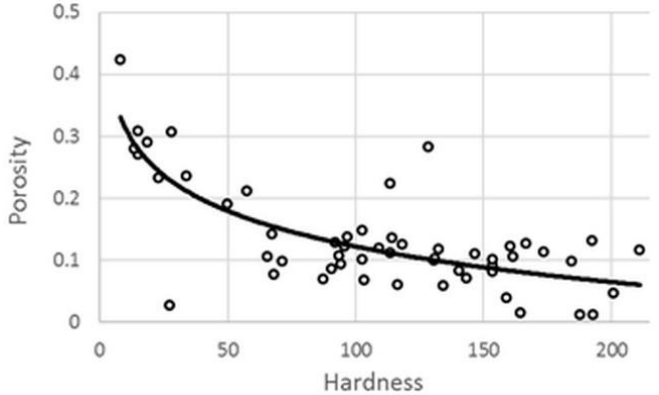
Figure 1. Hardness – porosity plot.